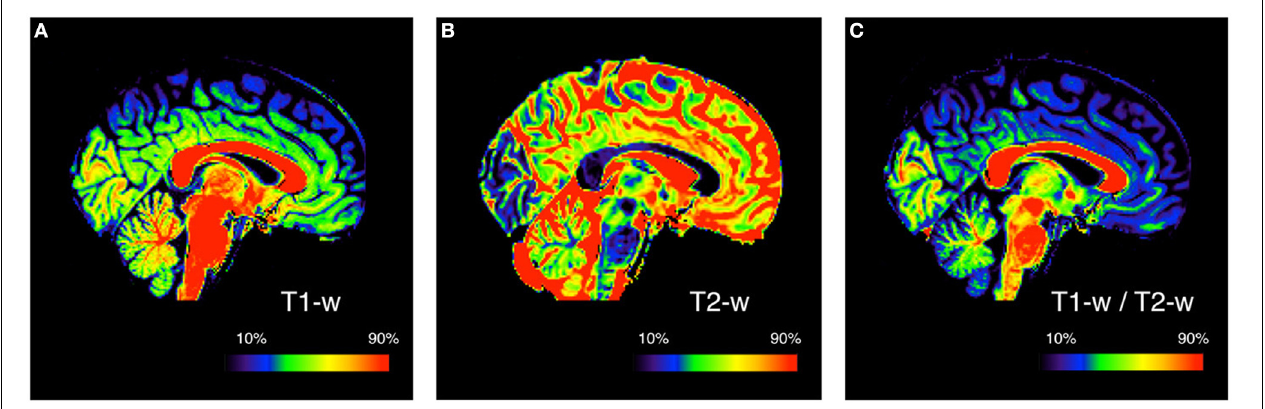
FIGURE 1 | Myelin enhanced contrast image for a representative subject. The ratio of T1-w (A) to T2-w (B) signal intensity is calculated to obtain the T1-w/T2-w ratio image (C) . This is done to improve the mapping by increasing the contrast between different myelinated structures. Since